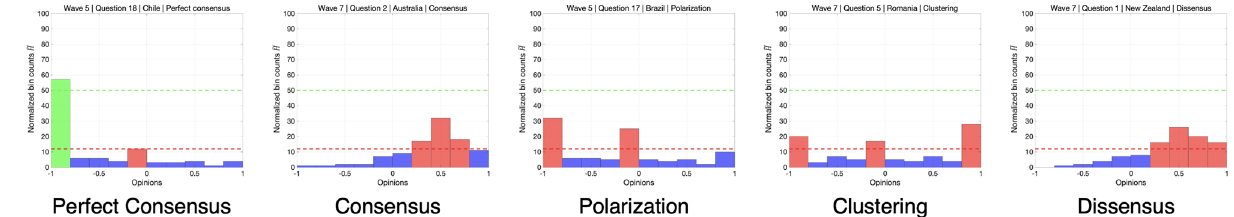
Figure 1. Examples of real-life opinion distribution histograms, taken from the World Values Survey data, classified as perfect consensus, consensus, polarization, clustering, and dissensus by the proposed histogram- based classification algorithm . The vertical axis represents the normalized bin counts thresholds T 1 (green) and T 2 (red). The bins are colored according to the histogram classification algorithm: green if the normalized bin count is larger than T 1 ; blue if it is smaller than T 2 ; red if it is between T 1 and T 2 . The parameter values we adopted to perform the classification are: M = 10 , B = 3 , K = 3 , T 1 = 50 , and T 2 = 12